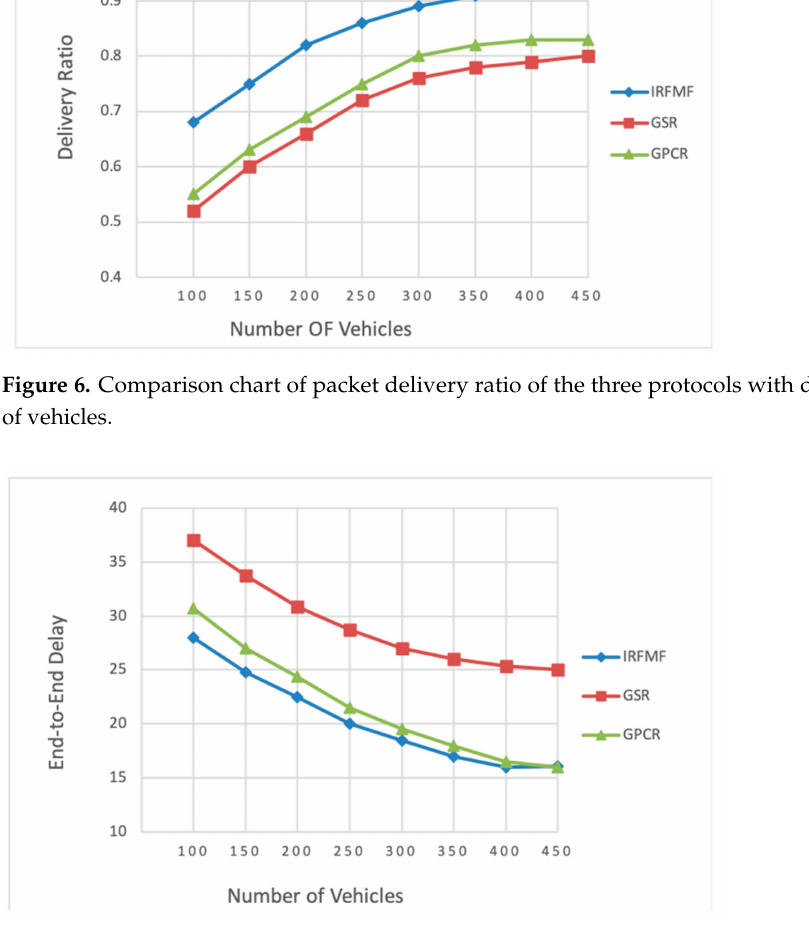
Figure 7. Comparison chart of average end-to-end delay of the three protocols with different numbers of